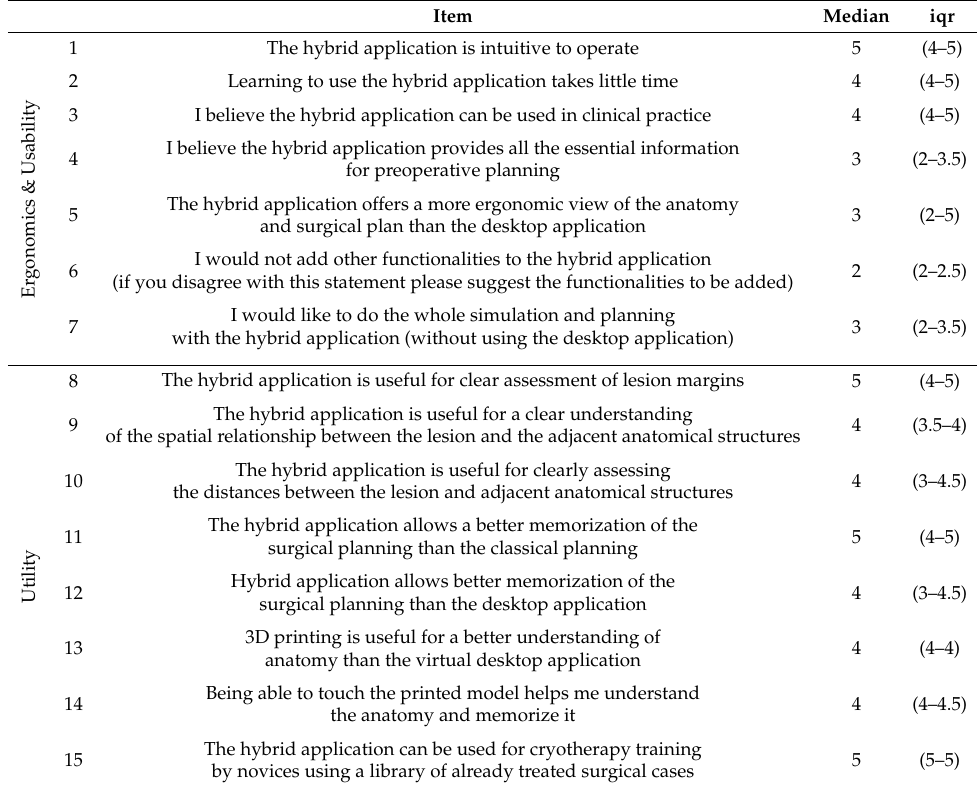
Table 5. Five point Likert questionnaire results for the Feedback on the Hybrid Plan (from 1 = strongly disagree, to 5 = strongly agree). The central tendency of responses is presented by the median, with the dispersion presented by the interquartile range (iqr).